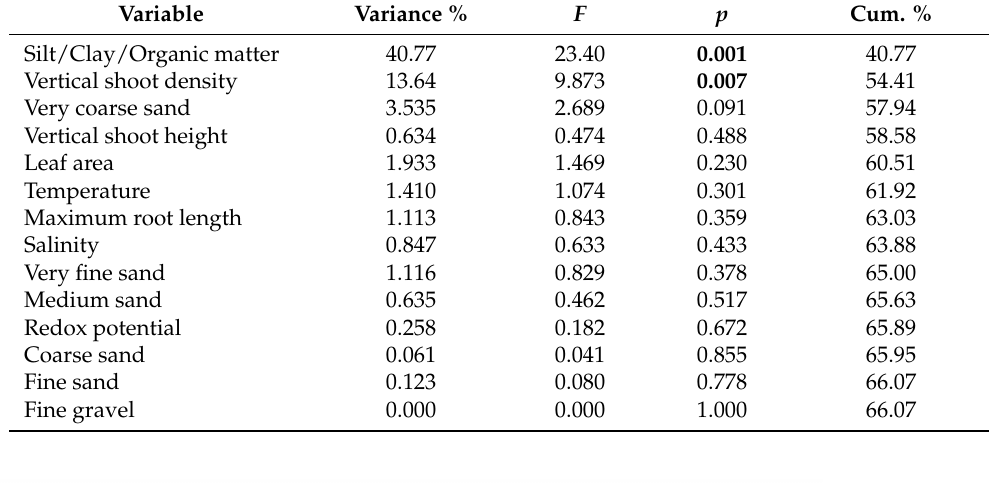
Table 2. Results obtained in the sequential test of the DISTLM analysis between the flowering effort, seagrass biometrics and abiotic parameters. Proportion: proportion of the variation in flowering effort explained by each variable; Cum. %: cumulative percentage of variance explained. Significant variables are highlighted in bold.